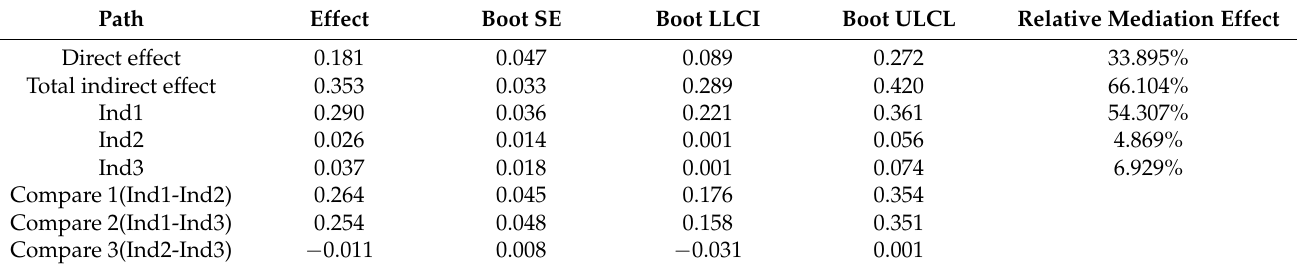
Table 3. Summary of indirect effects using the bootstrapping